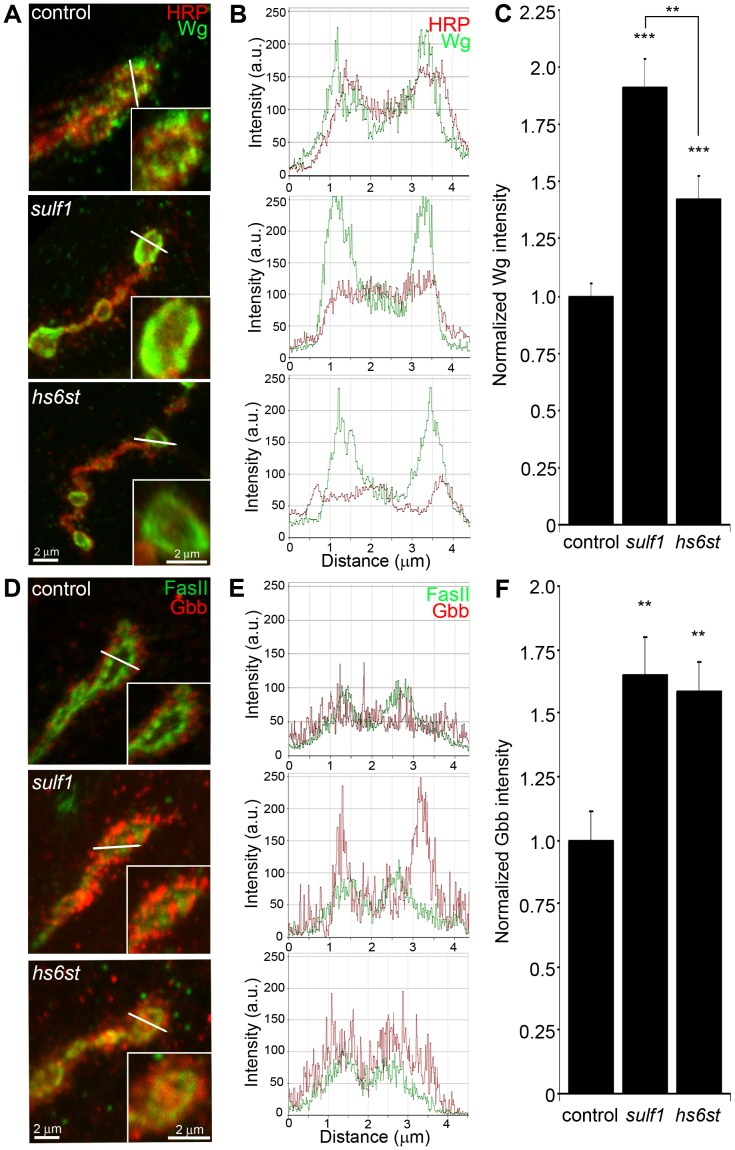
Synaptic WNT and BMP ligand abundance is modified by 6-O-S sulfation.Images show muscle 6 NMJ in segment A3 probed in non-detergent conditions, so that only extracellular protein distributions are detected. The white lines indicate cross-section planes for spatial measurements. Insets indicate single synaptic boutons at higher magnification. (A) Representative NMJ boutons from control (w1118), sulf1 and hs6st null genotypes, labeled for presynaptic anti-horseradish peroxidase (HRP, red) and anti-wingless (Wg, green). (B) Extracellular distribution of Wg across the diameter of a synaptic bouton. The Y-axis indicates intensity and the X-axis shows distance in microns. The HRP intensity profile is indicated in red; Wg intensity is shown in green. (C) Quantification of Wg mean intensity levels normalized to the HRP co-label, and to genetic control. Sample sizes are at least 15 animals per indicated genotypes. (D) Representative synaptic boutons labeled with presynaptic anti-Fasciclin II (FasII; green) and anti-Glass Bottom Boat (Gbb; red). (E) Gbb distribution across the diameter of a synaptic bouton. Y-axis indicates intensity and the X-axis shows distance in microns. FasII intensity profile is indicated in green; Gbb intensity is shown in red. (F) Quantification of Gbb mean intensity levels normalized to genetic control. Sample sizes are at least 11 independent NMJs of at least 7 animals per indicated genotypes. Statistically significant differences calculated using student's t-test and Mann-Whitney test for non-parametric data, ** p<0.01, *** p<0.001. Error bars indicate S.E.M.